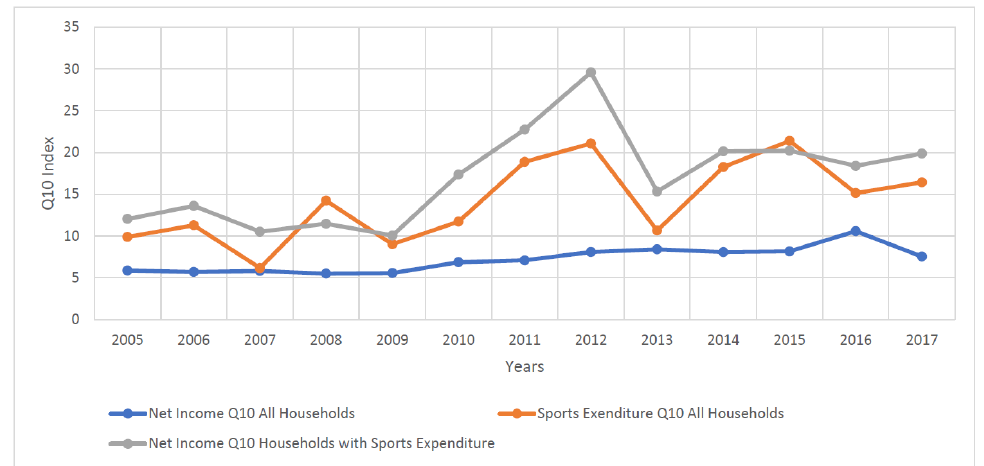
Figure A4. Q10 inequality indices in the time period 2005 – 2017. Source: own calculation.